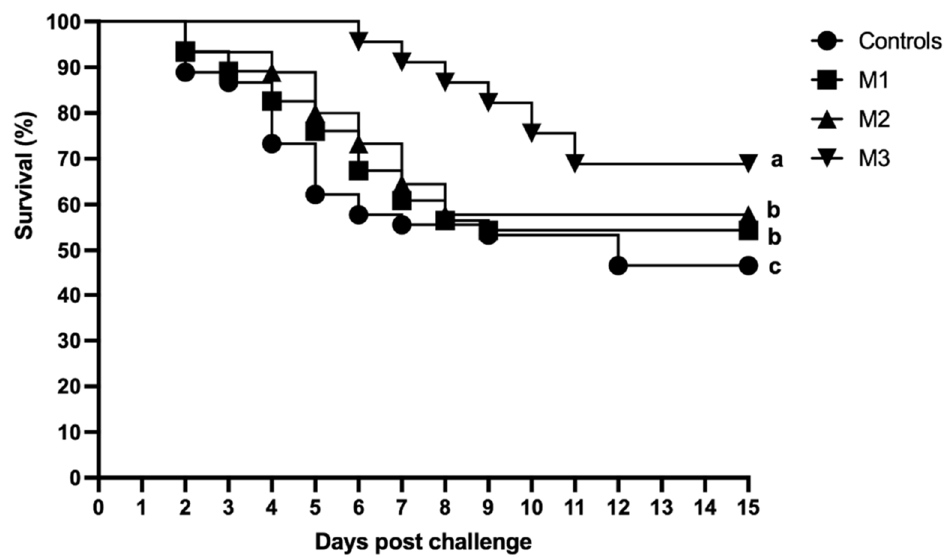
Figure 4. Survival rate of C. carpio fed a basal diet incorporated with zero (control), 0.5% (M1), 1% (M2), and 2% (M3) of Myristica fragrans following experimental challenge with A. hydrophila (1.3 × 10 8 CFU mL −1 ) for 15 days. Each curve represents the mortality mean of 3 tanks/treatment. Different letters indicate significant differences ( p < 0.05).